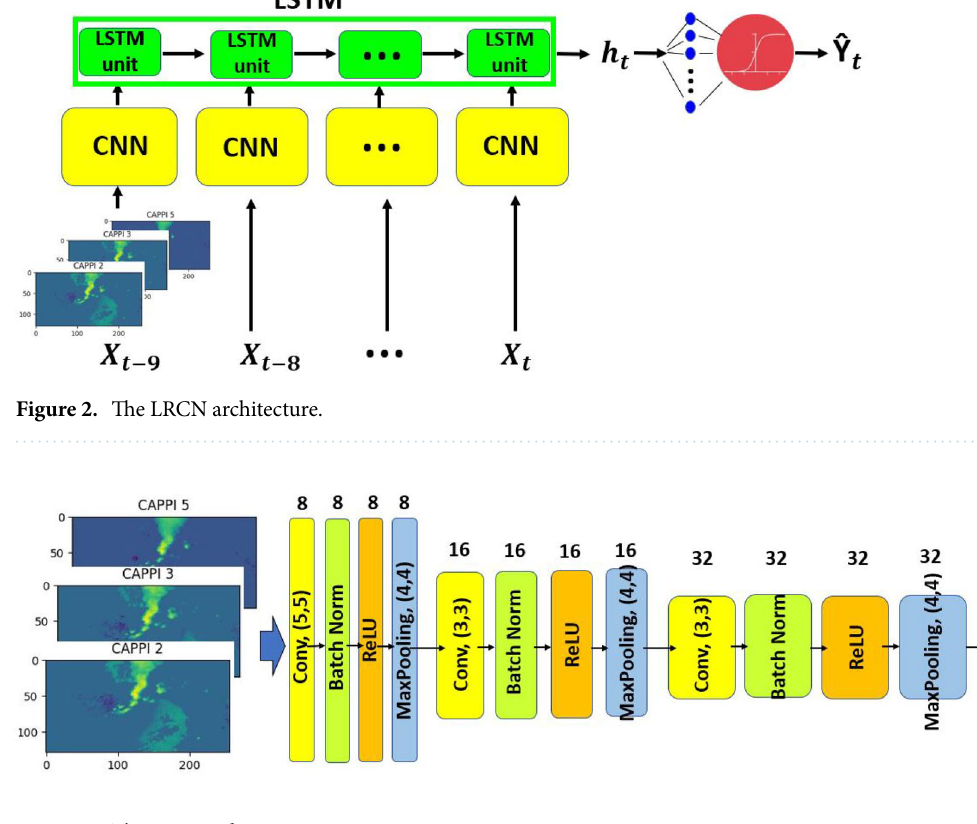
Figure 3. The CNN